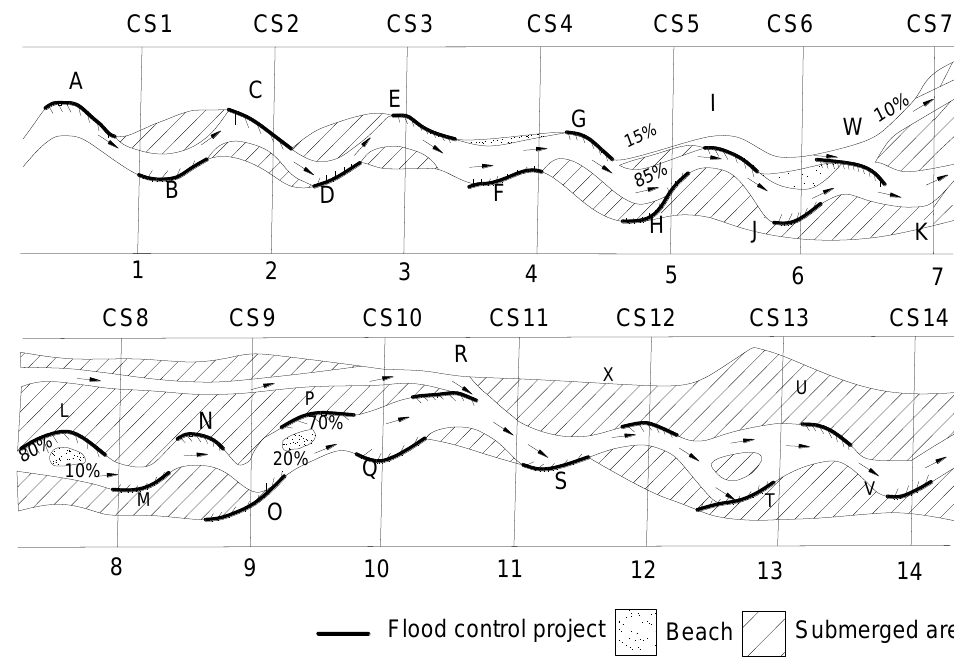
Figure 3. River regime after 7 h of water release in Group N1 test.